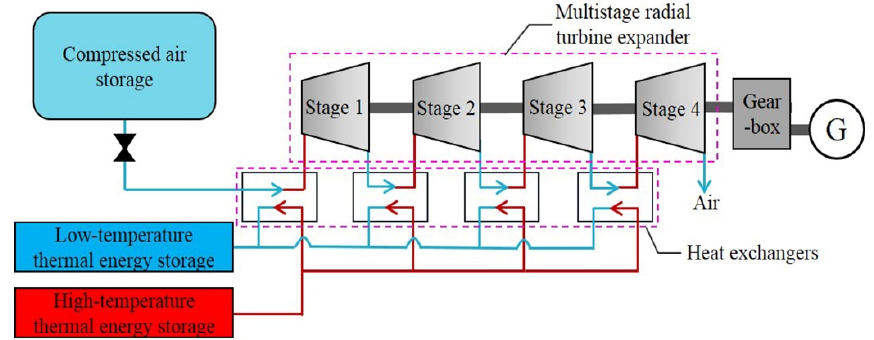
Figure 1. Schematic diagram of a multistage radial turbine in a compressed air energy storage (CAES) system.